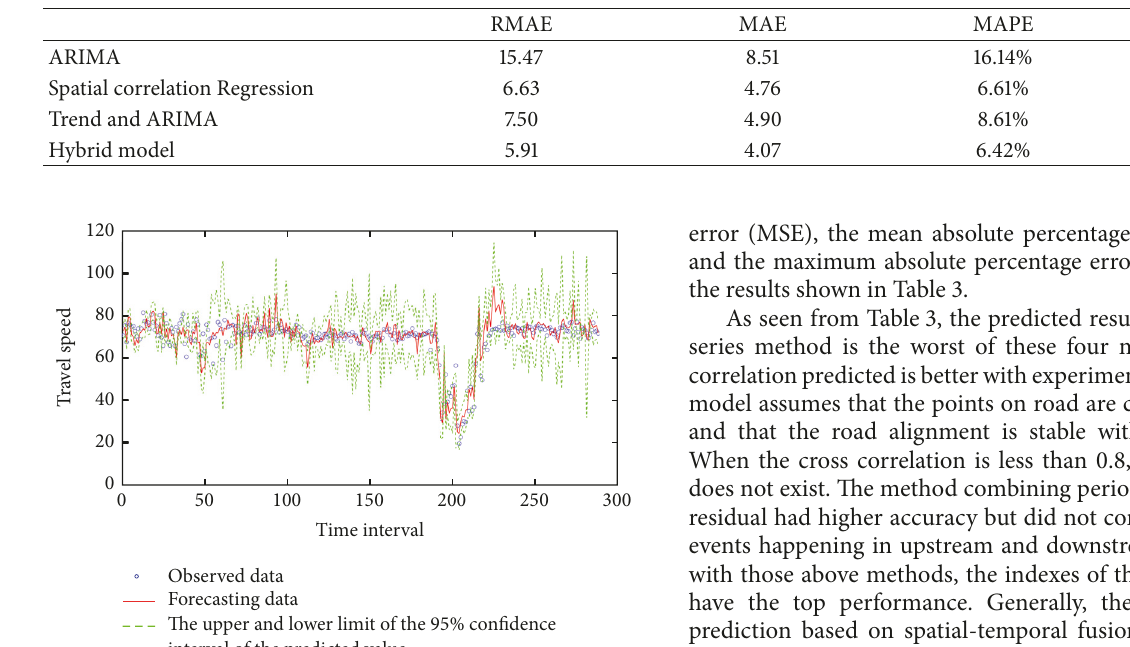
Table 3: Evaluation index of different prediction method.